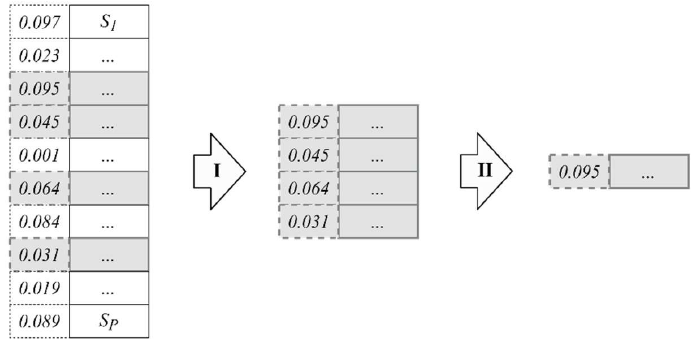
Figure 3. Four-way tournament selection in a P -size population { S 1 , …, S P }: I—random selection of four individuals, II—selection of the best (most fit) individual.